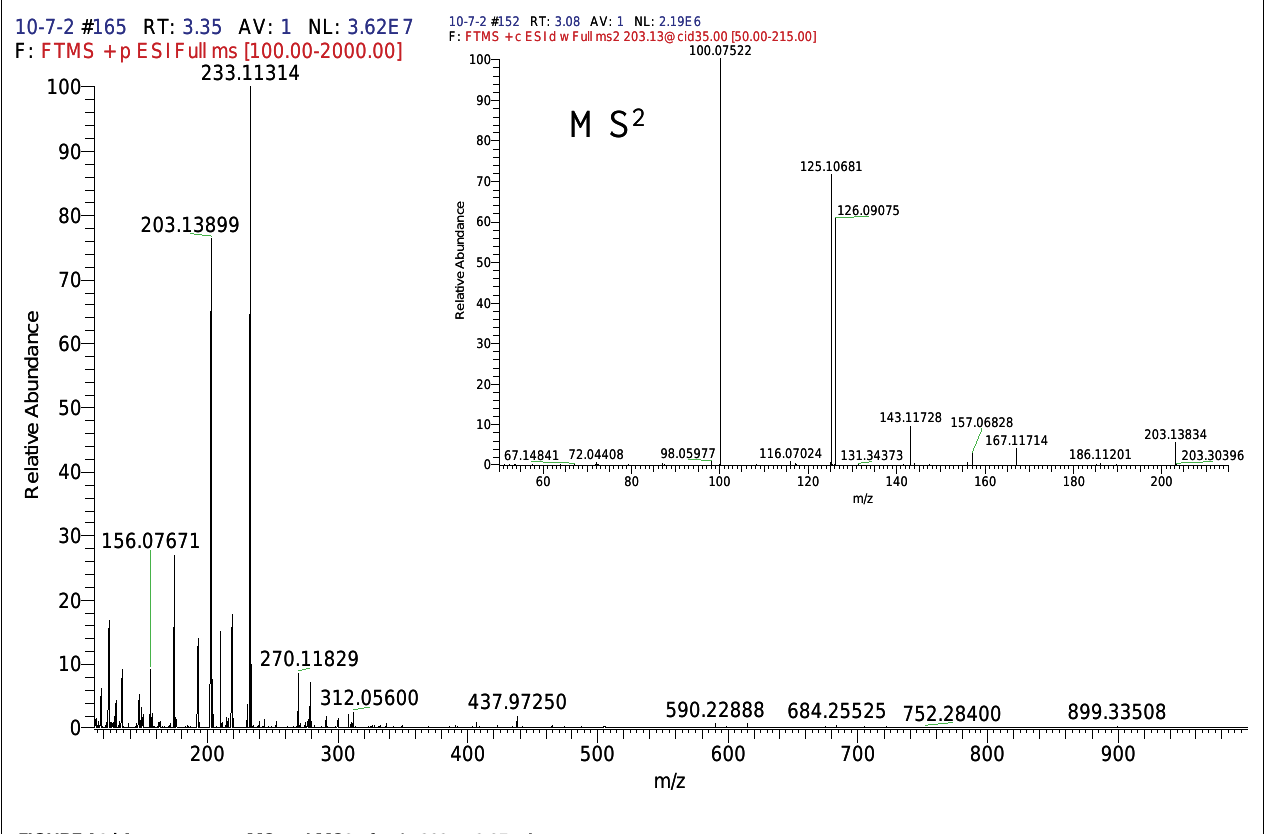
FIGUREA9 |Accurate mass MS and MS2 of m / z 203 at